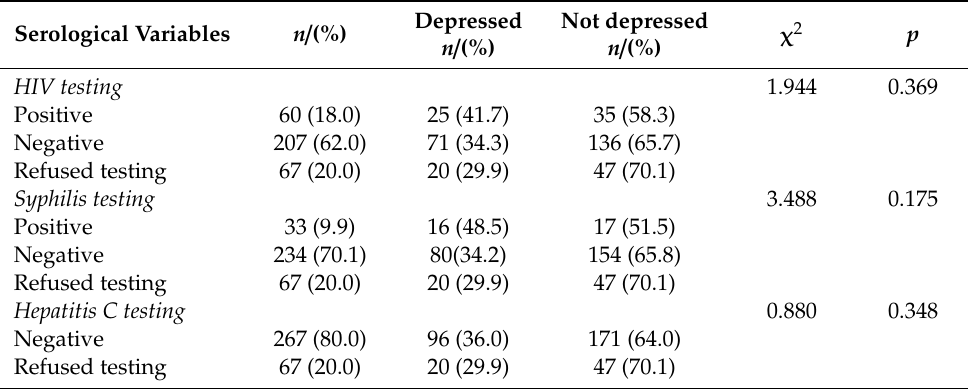
Table 4. Descriptions of serological results.